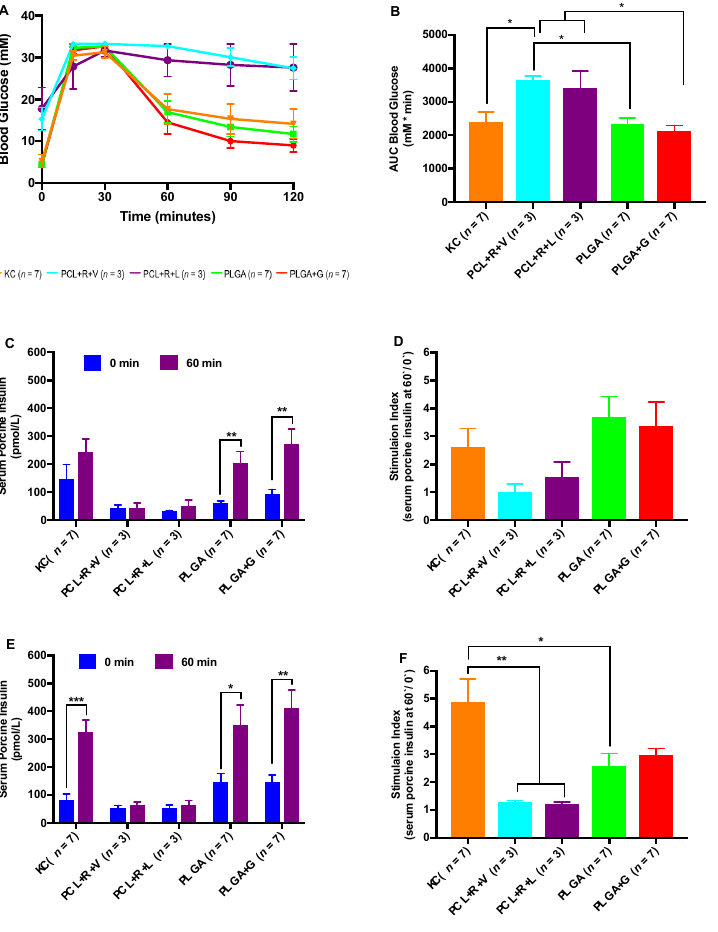
Figure 4. Intraperitoneal glucose challenge and stimulated porcine insulin secretion post-transplant. Transplanted recipients were subjected to an intraperitoneal glucose tolerance test (IPGTT) at 20 weeks post-transplant. Blood glucose during an IPGTT ( A ) and area under the curve for respective IPGTT (( B ) * p < 0.05, one-way ANOVA). Porcine-stimulated serum insulin secretion prior to (0 min) and following 60 min after an i.p. injection of a glucose bolus was measured at 10 (( C ) ** p < 0.01, two- tailed unpaired t -test) and 20 (( E ) * p < 0.05, ** p < 0.01, *** p < 0.001, two-tailed unpaired t -test) weeks post-transplant. Calculated stimulation index for porcine-stimulated insulin secretion at 10 weeks ( D ) and 20 weeks post-transplant (( F ) * p < 0.05, ** p < 0.01, one-way